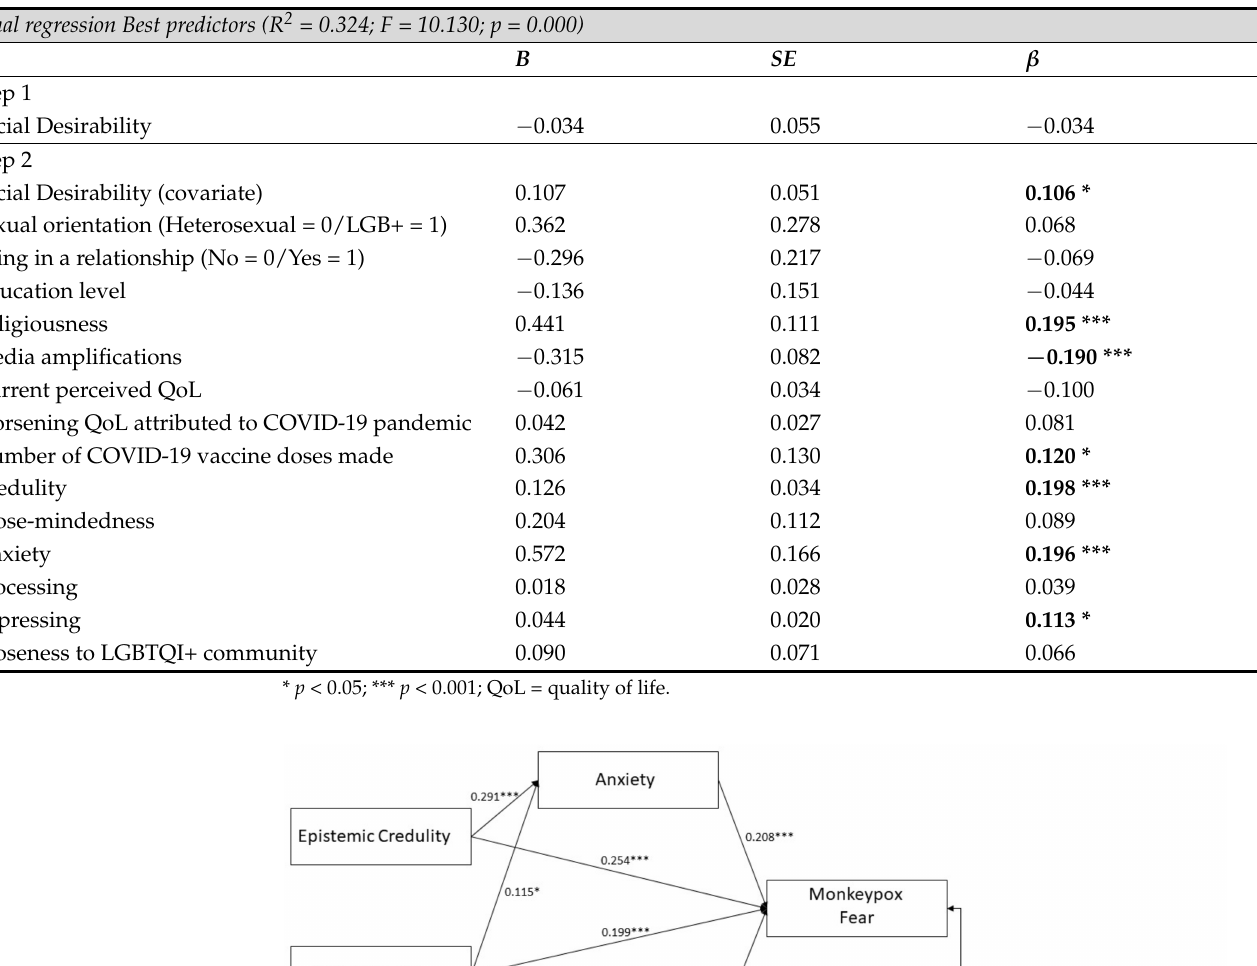
Table 7. Final hierarchical multiple regression analyses on best predictors emerged (n = 333).